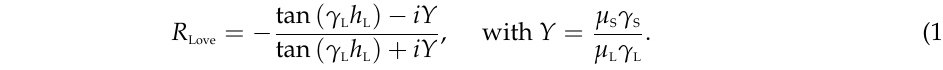
= h + h = 8 of the layer are kept constant; (cid:96) = 1 and ϕ L L t = h = b t